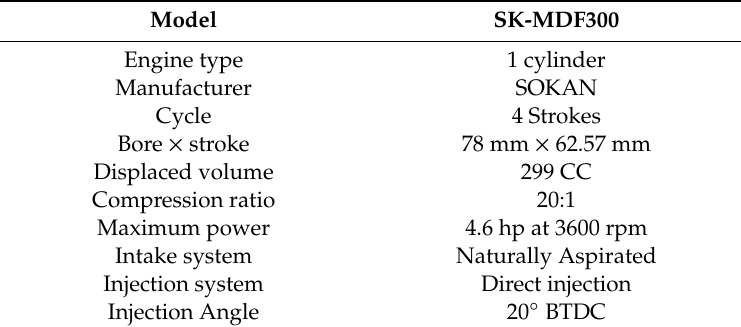
Table 1. Specifications of the diesel engine.